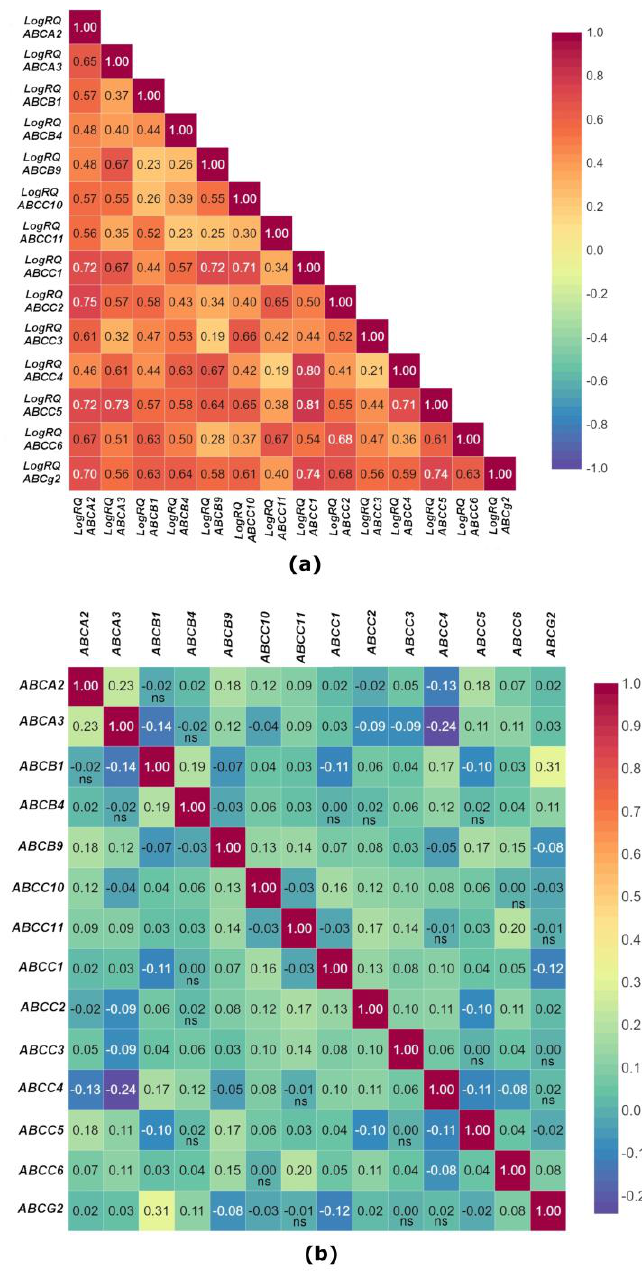
Figure 3. The figure shows correlation analyses of mean expression values of selected genes from the ABC family in patients with triple-negative breast cancer ( a ) and correlation analyses of mean expression values of tested genes in breast cancer obtained from the TCGA and SCAN-B database using Breast Cancer Gene Expression Miner v4.8 online tool (r — Pearson ’ s correlation coefficient) ( b